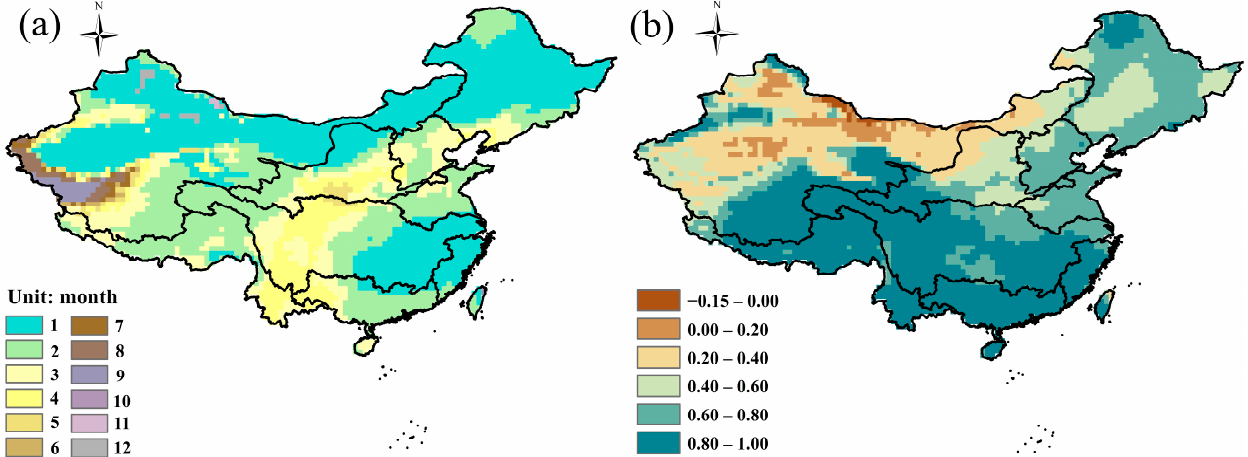
Figure 2. Propagation time ( a ) and spatial distribution of the maximum Pearson correlation coefficient values ( b ) between the SPI and SRI for the period 1902–2014.